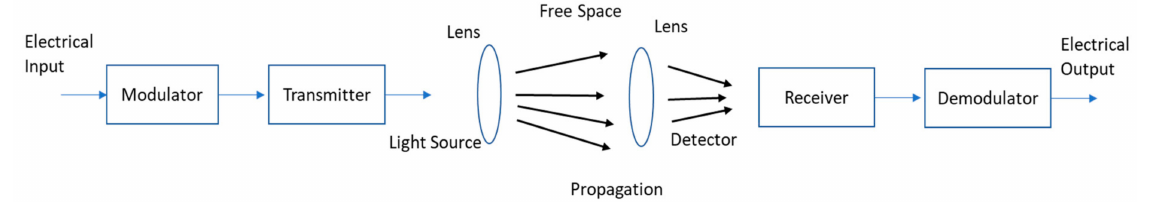
Figure 4. Free space optical communication block diagram. Adapted from